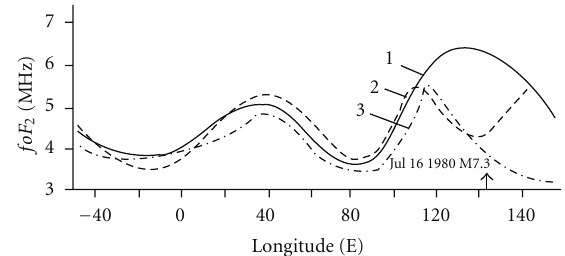
Figure 1: Longitudinal distributions of the critical frequency foF2 obtained by IS-338 topside sounder (Intercosmos-19 satellite) at the latitude 3N for the fixed local time (05-06LT). Bold line (1): averaged quiet time distribution; dash-dot line (2): distribution obtained for 14 July 1980; dashed line (3): distribution obtained on 15 July